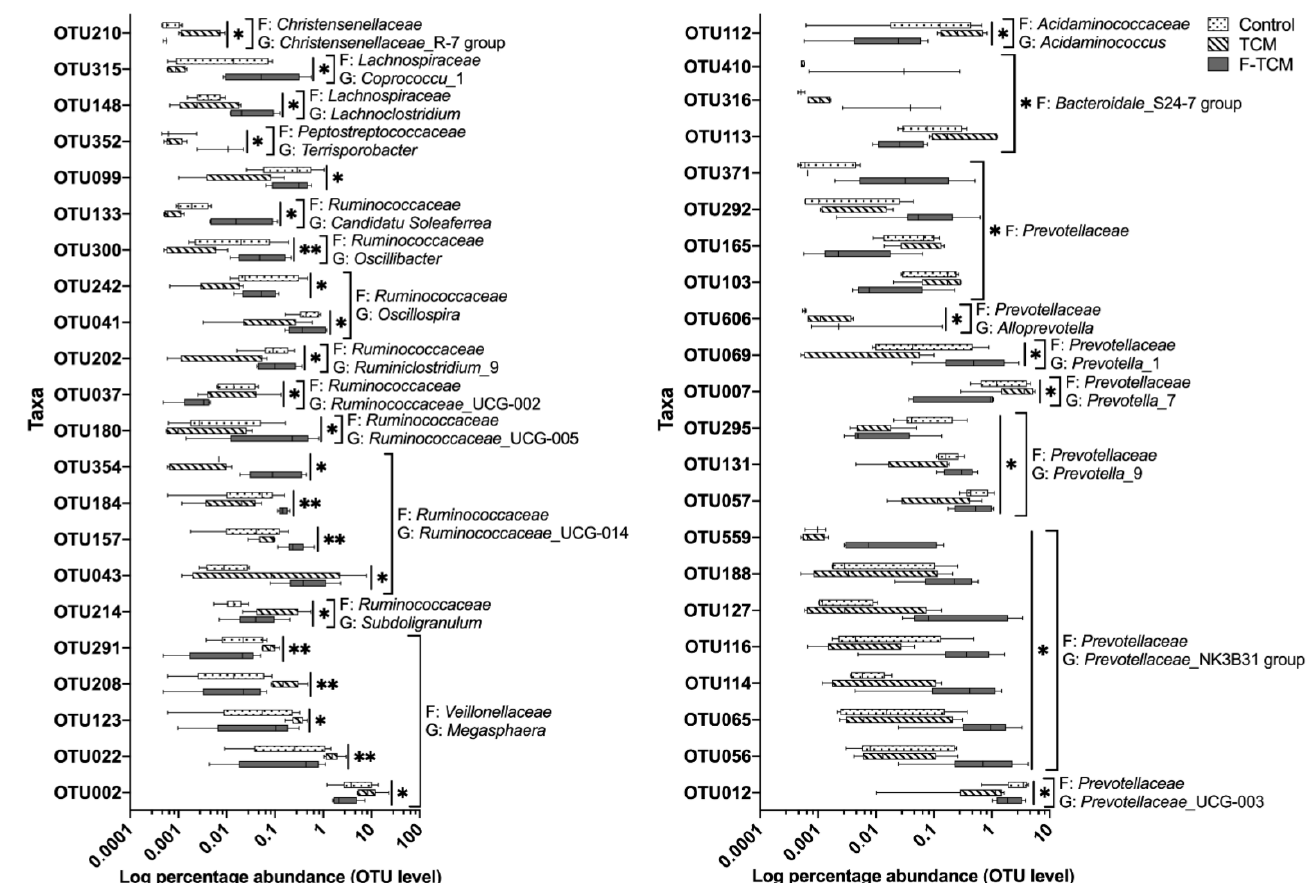
Figure 5. The relative abundance of the fecal microbiota of weaned piglets at the OTU level. F: family; G: genus. * indicate significant differences among three groups ( p < 0.05), ** indicate significant differences among three groups ( p < 0.01).